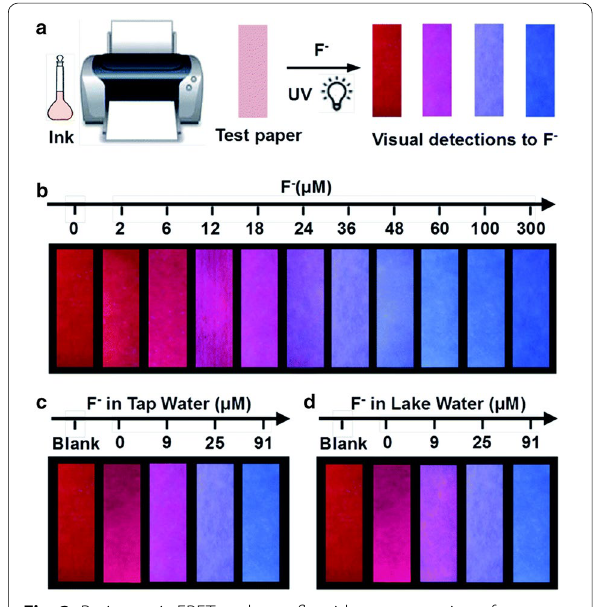
Fig. 3 Ratiometric FRET to detect fluoride concentration of water samples on paper‑based substrates: a test paper preparation; b F ‑ detection in DI water; c in tap water; d in lake water (reproduced from [58], published by Royal Society of Chemistry with open access)